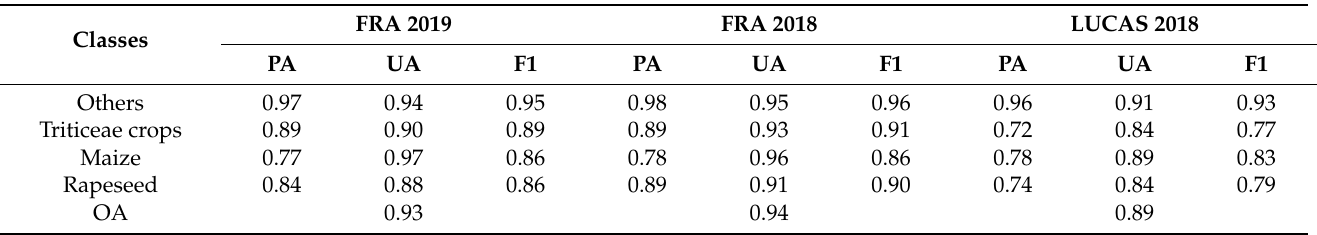
Table 4. Classification accuracy of the point-based validation for France and the whole study area using LUCAS